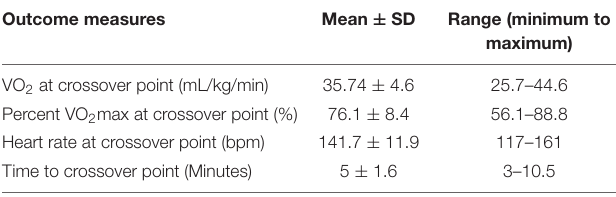
TABLE 2 | Outcome measures assessed during the maximal graded exercise test.